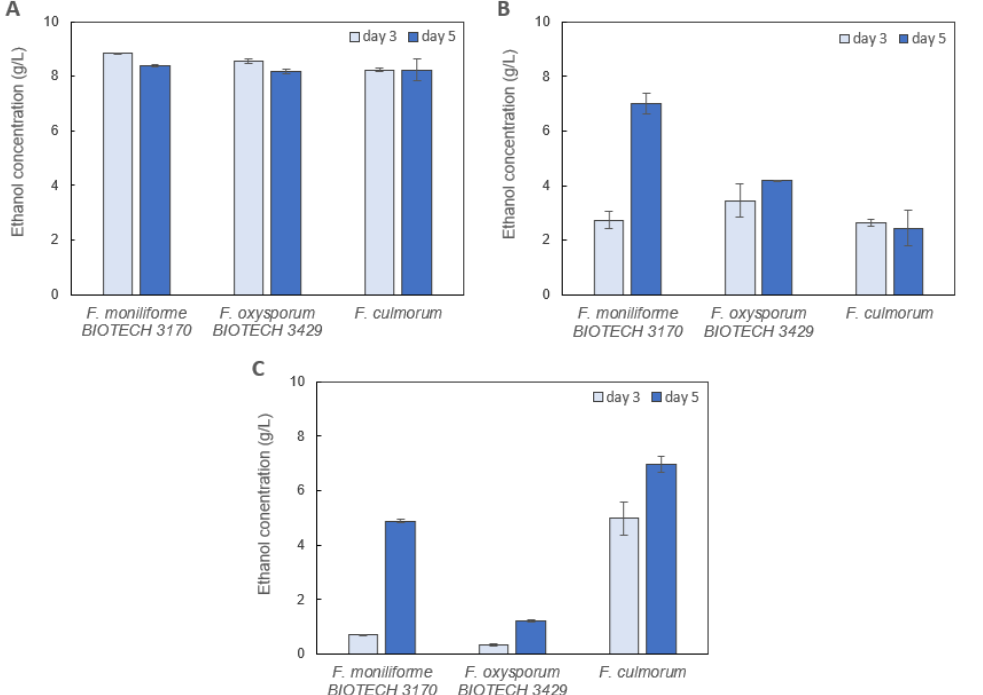
Figure 1. Ethanol production from ( A ) glucose, ( B ) xylose, and ( C ) cellobiose by various fungi after 3 and 5 days.